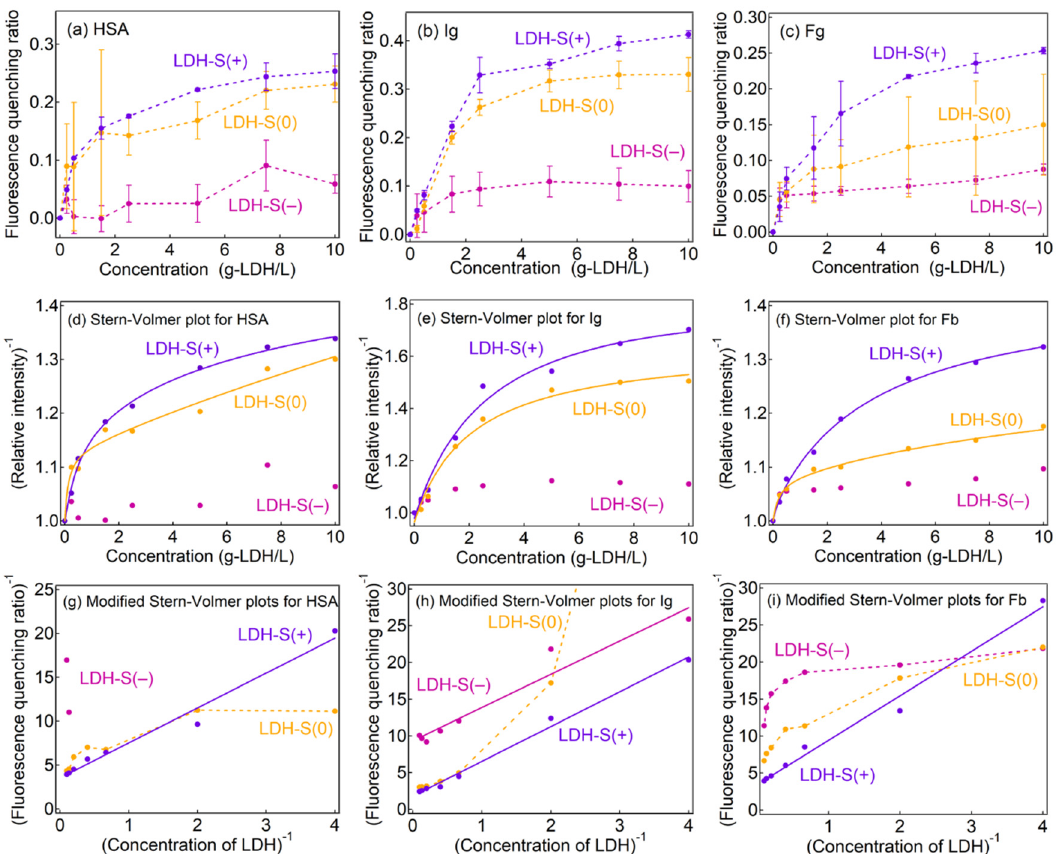
Figure 4. ( a – c ) Fluorescence quenching ratios of the three proteins, ( d – f ) Stern–Volmer plots and ( g – i ) modified Stern–Volmer plots for (left column) HSA, (middle column) Ig and (right column) Fb. Solid lines: fitting lines by ( d – f ) Equation (7) and ( g – i ) Equation (6), dotted lines: connecting the experimental data to clarify.